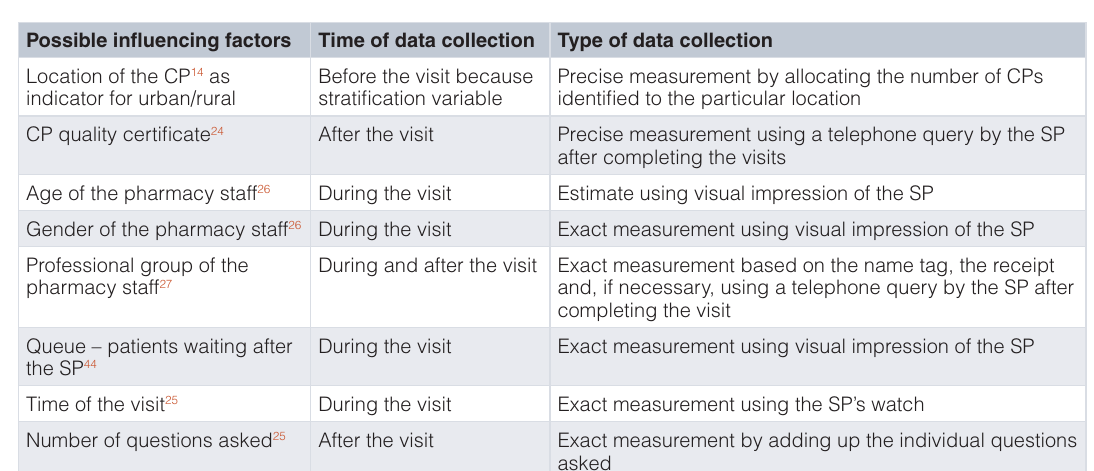
Table 2. Possible influencing factors and time and type of data